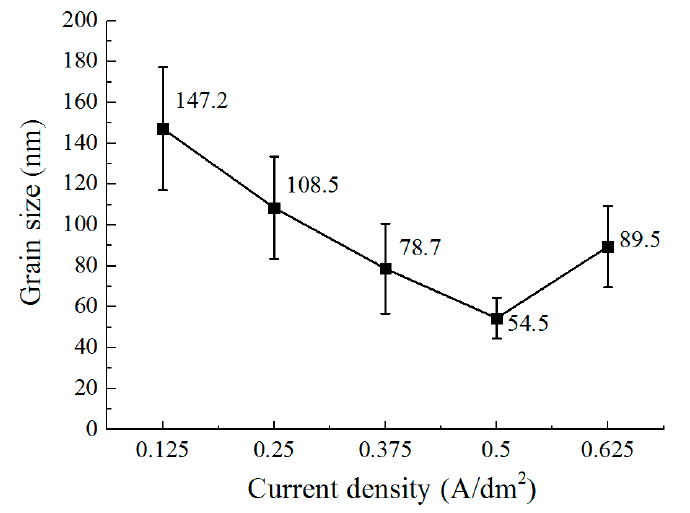
Figure 11. The effect of current density on the grain size.